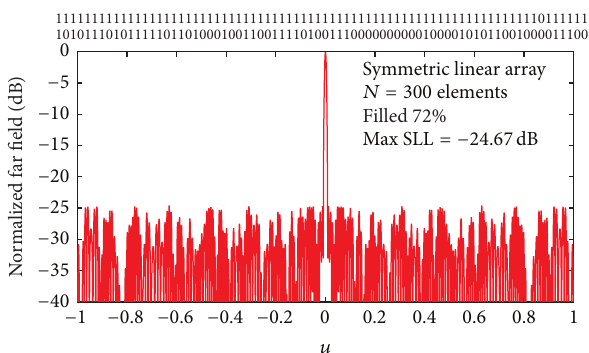
Figure 2: Radiation pattern of the best obtained array for the 300- element symmetric thinned